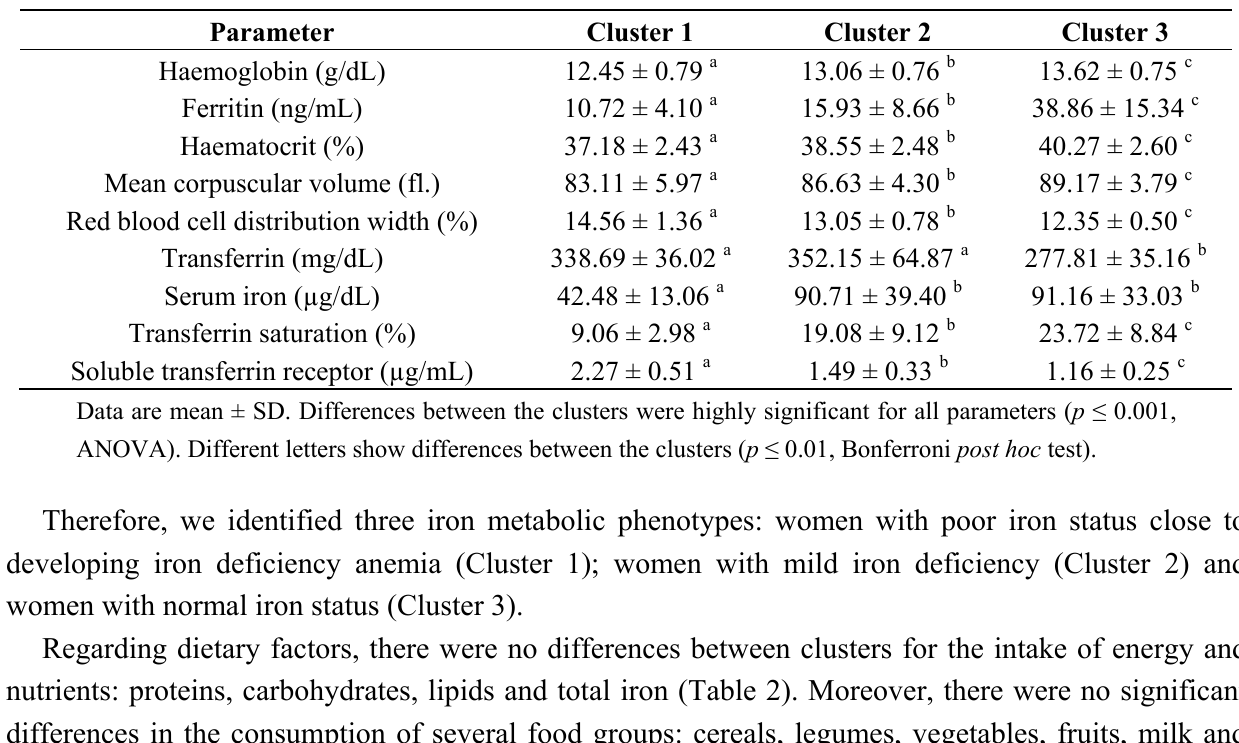
Table 1. Iron biomarkers according to the